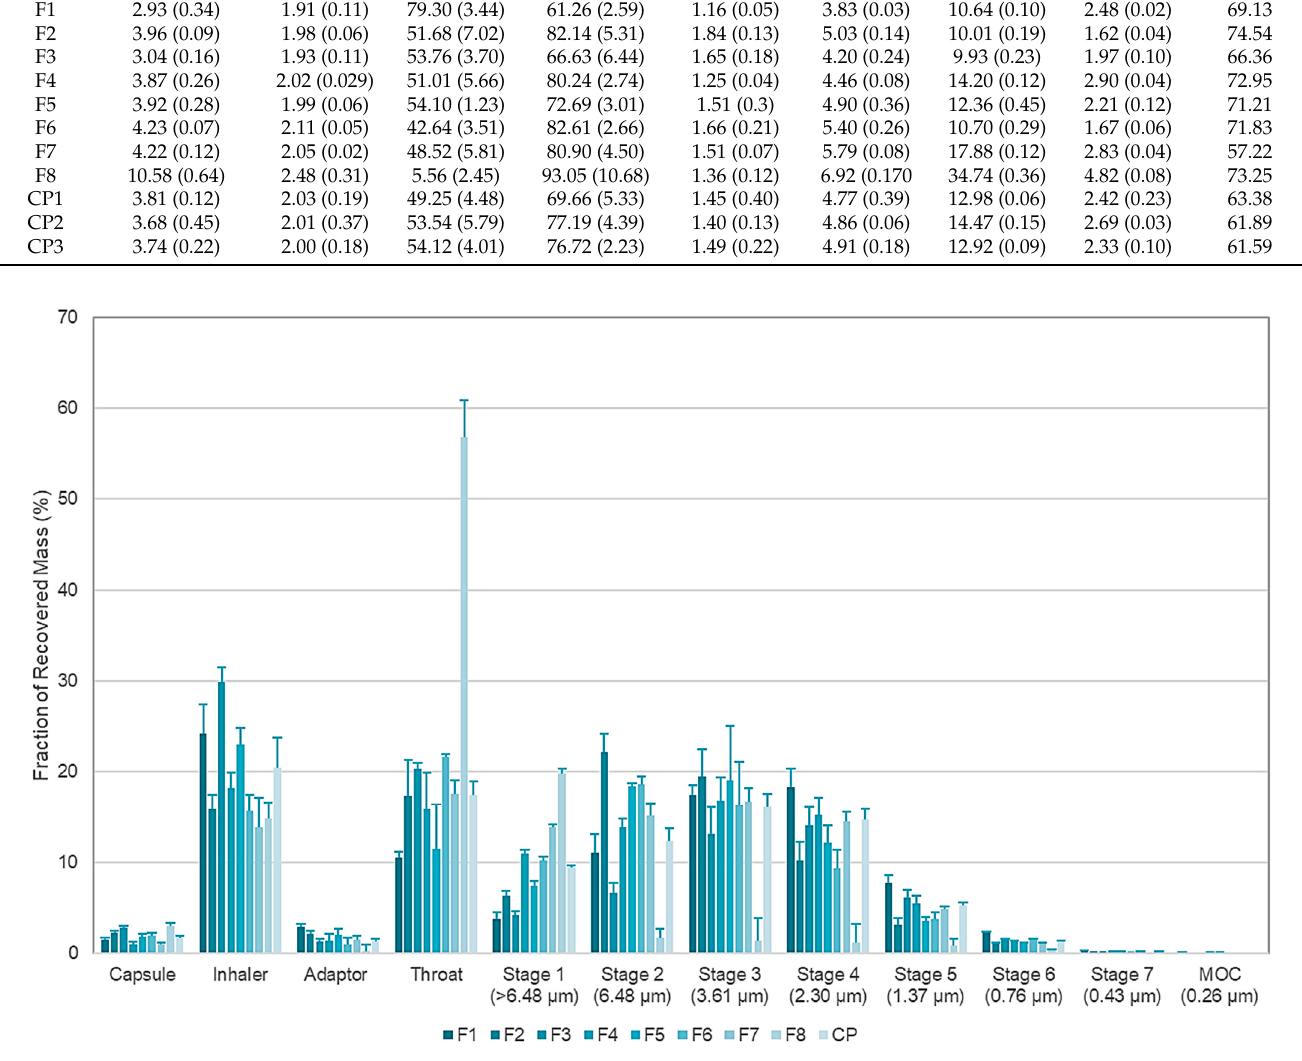
Figure 6. NGI deposition patterns of spray-dried FAV-THP formulations with the corresponding upper aerodynamic cutoff diameter specified. MOC: the micro-orifice collector in the NGI.